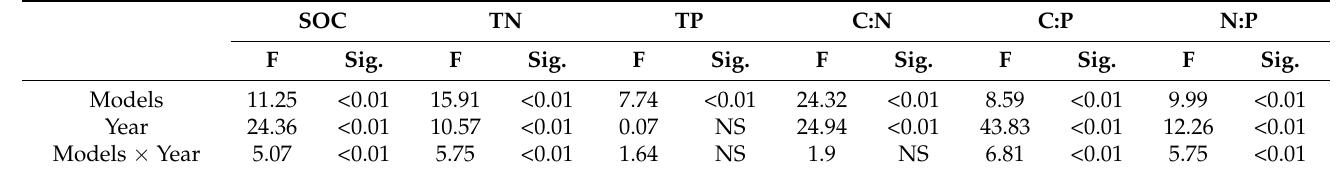
Table 1. F and p -values for the independent factors (models, year) and their